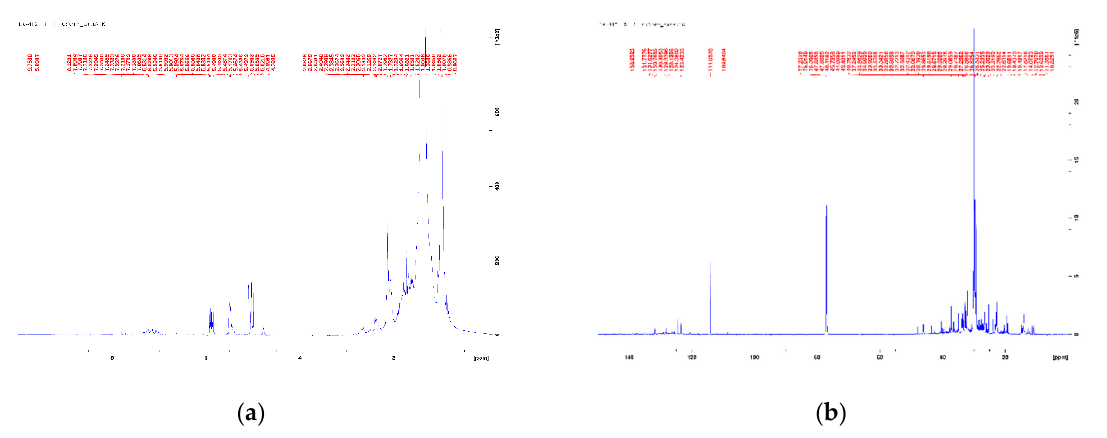
Figure 3. ( a ) 1 H NMR spectra and ( b ) 13 C NMR spectra of the blend Algae/HDPEwax 25/75.